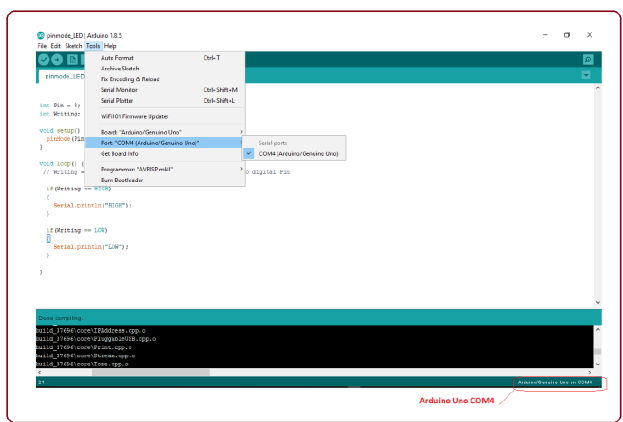
Figure 6. Microcontroller Arduino Nano